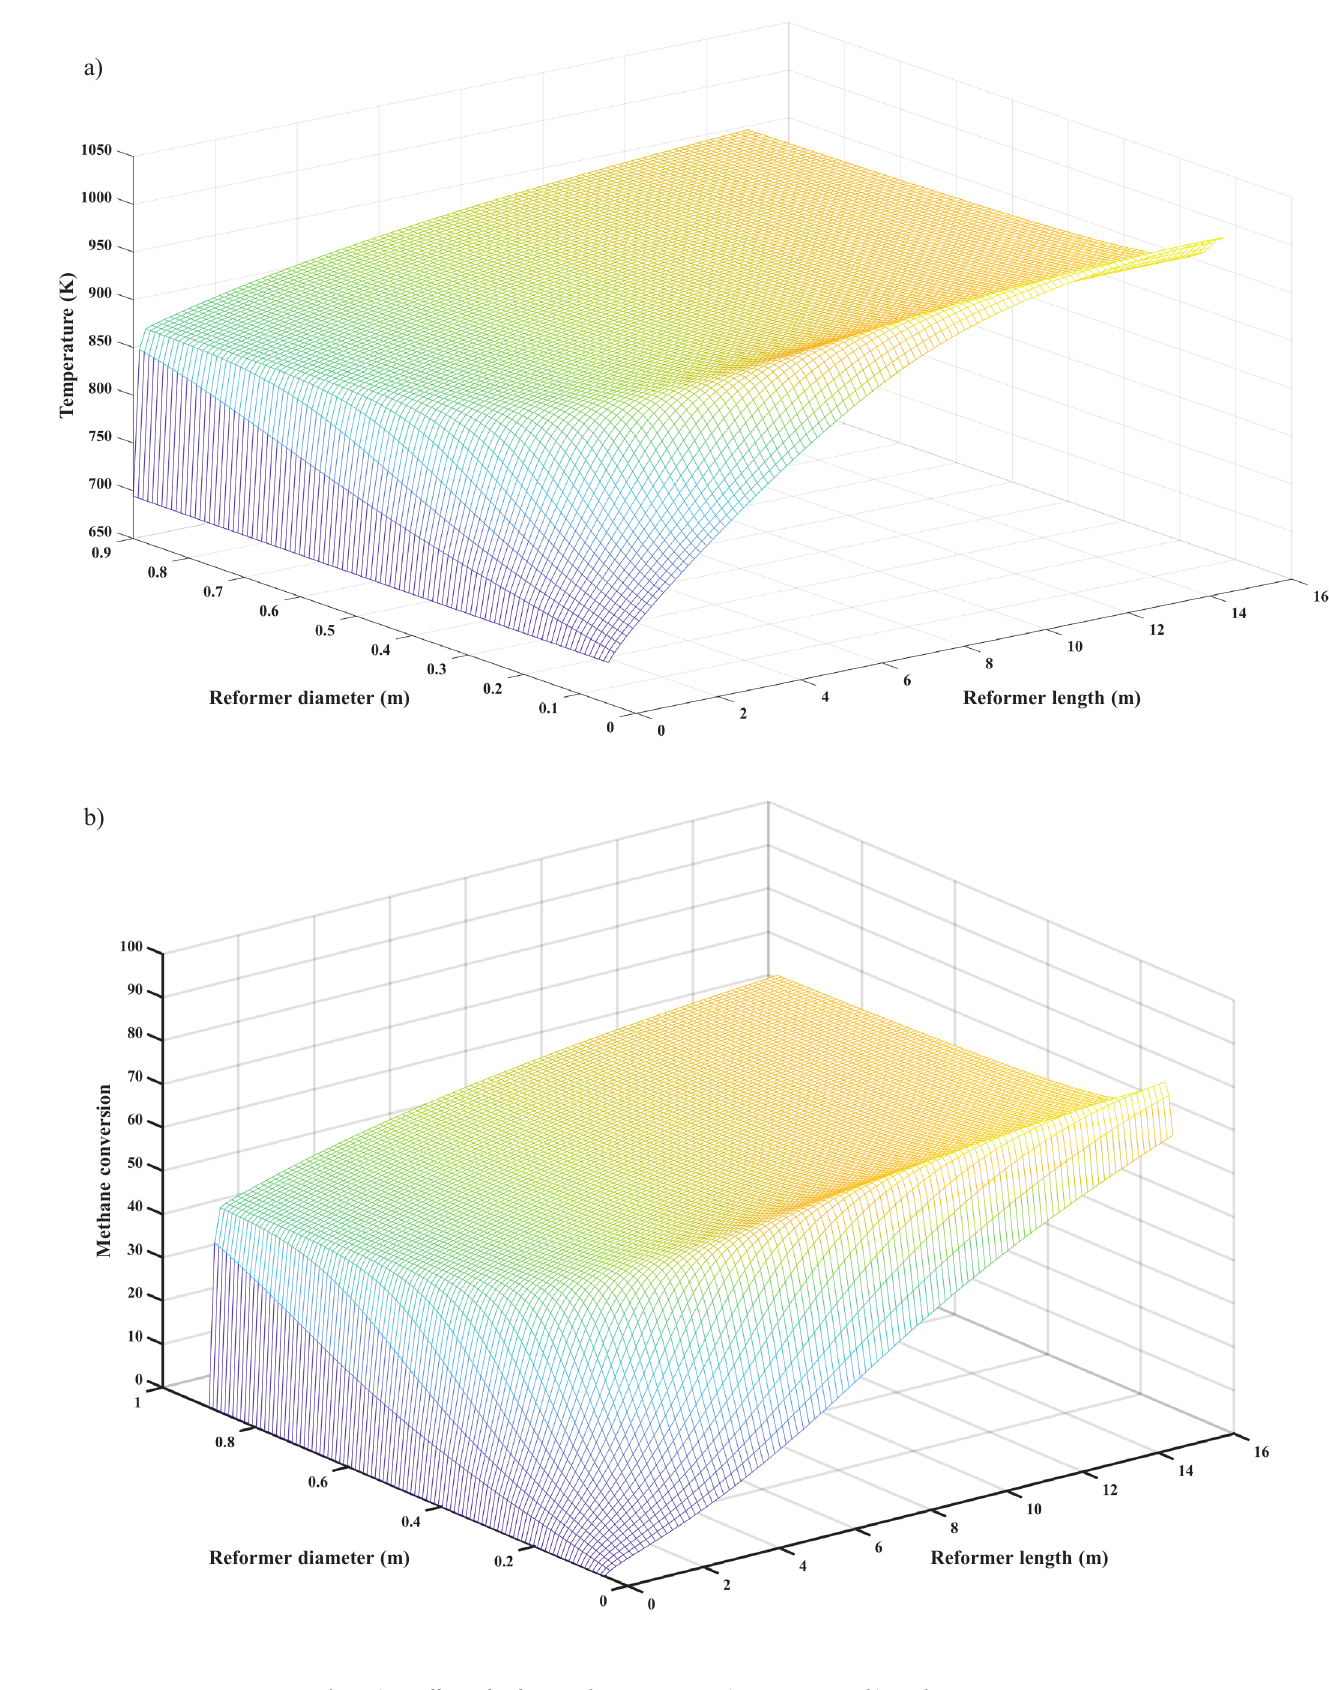
Fig. 6 – Effect of reformer dimension on: a) temperature, b) methane